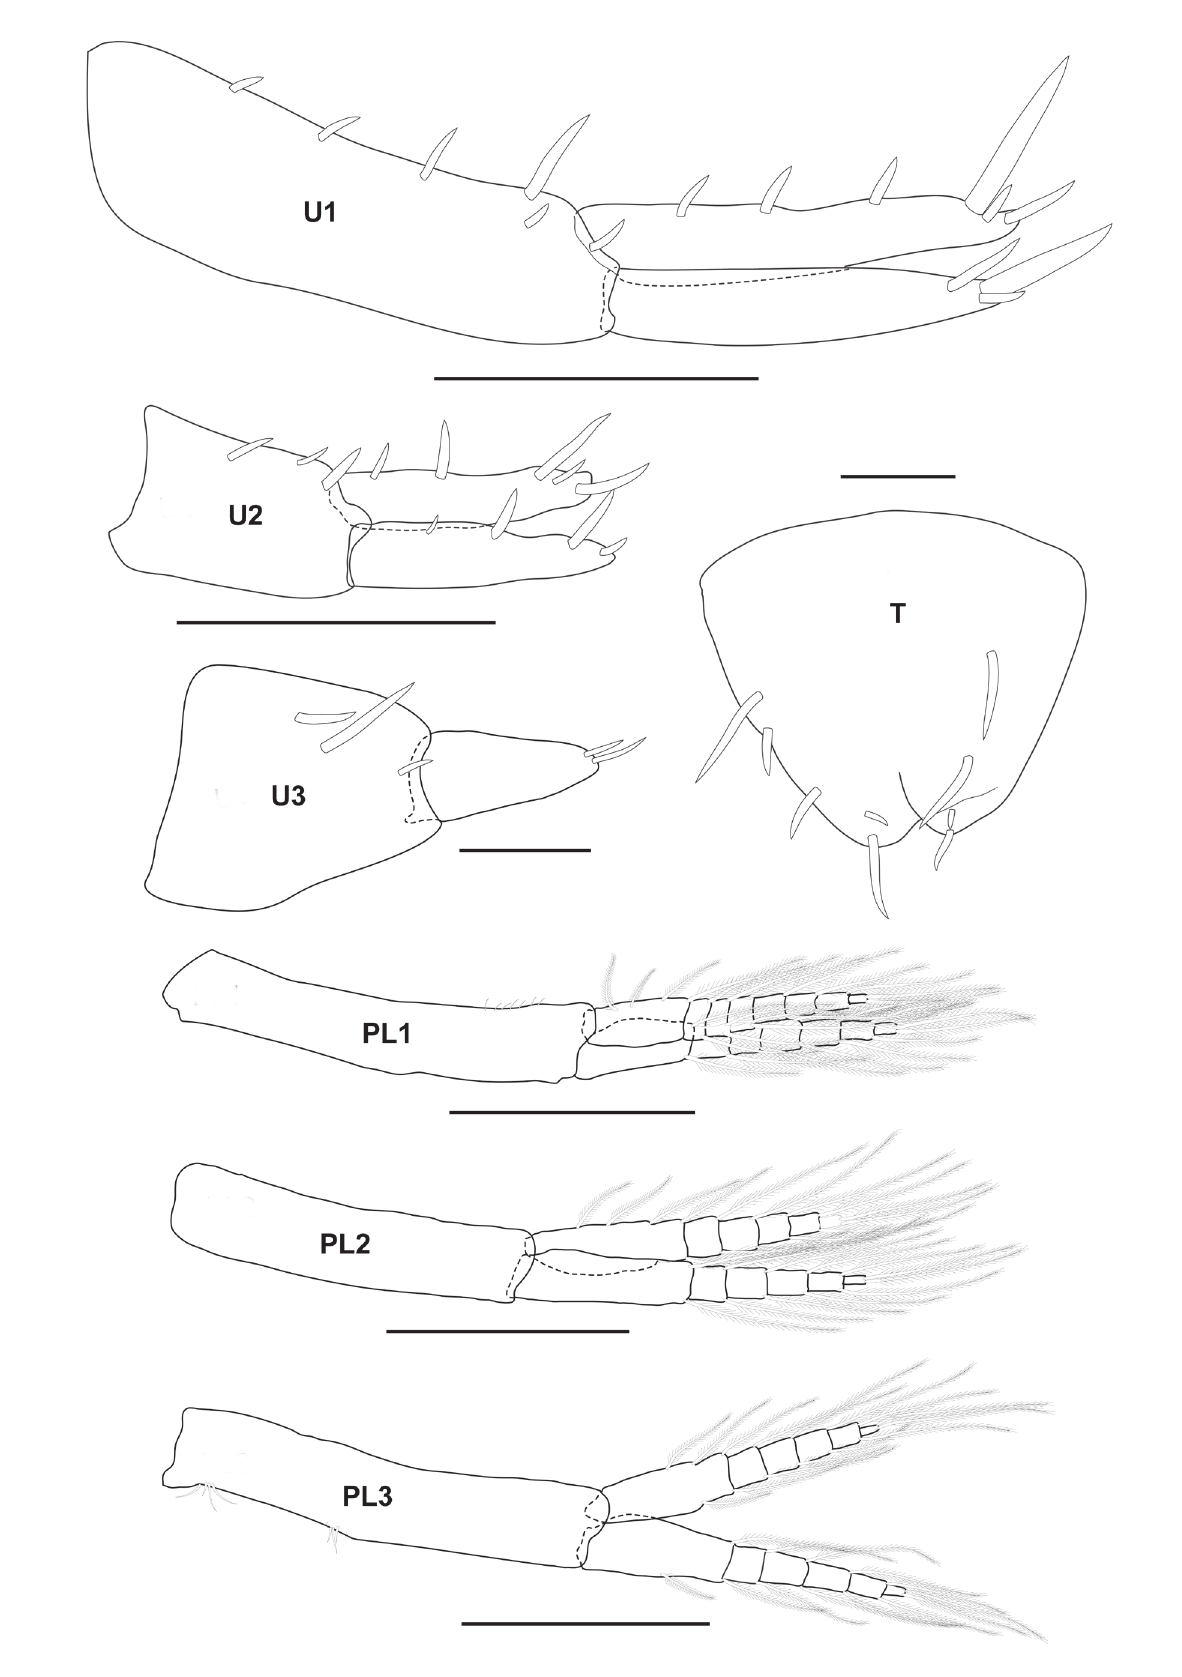
Figure 10. Floresorchestia samroiyodensis sp. n., allotype, male, (PSUZC-CR-0274) 10.5 mm. Khao Sam Roi Yod National Park. Scales for U1, U2, PL1, PL2 and PL3 represent 0.5 mm; U3 represent 0.1 mm; T represents 0.2